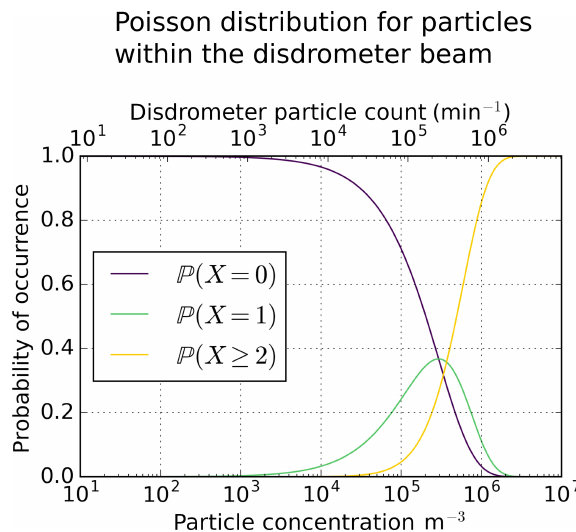
Figure 2. Probability of X number of drops residing within the dis- drometer beam for a given drop concentration. If two or more drops are within the beam simultaneously, data quality can be reduced. More than 12000dropsm − 3 (equivalent to 10000dropsmin − 1 recorded by the disdrometer ∗ ) are required before the probability of two or more drops occurring in the beam simultaneously be- comes non-negligible. As such, any events with more than 10000 drops observed per minute should be treated as less reliable. ∗ Drops falling through the disdrometer beam assume a 3ms − 1 fall velocity, which from Gunn and Kinzer (1949) is a particle of approximately 0.8mm diameter, typically the average size observed for a moderate rainfall event. Droplet breakup on the housing of the Thies LPM is not factored into this test.